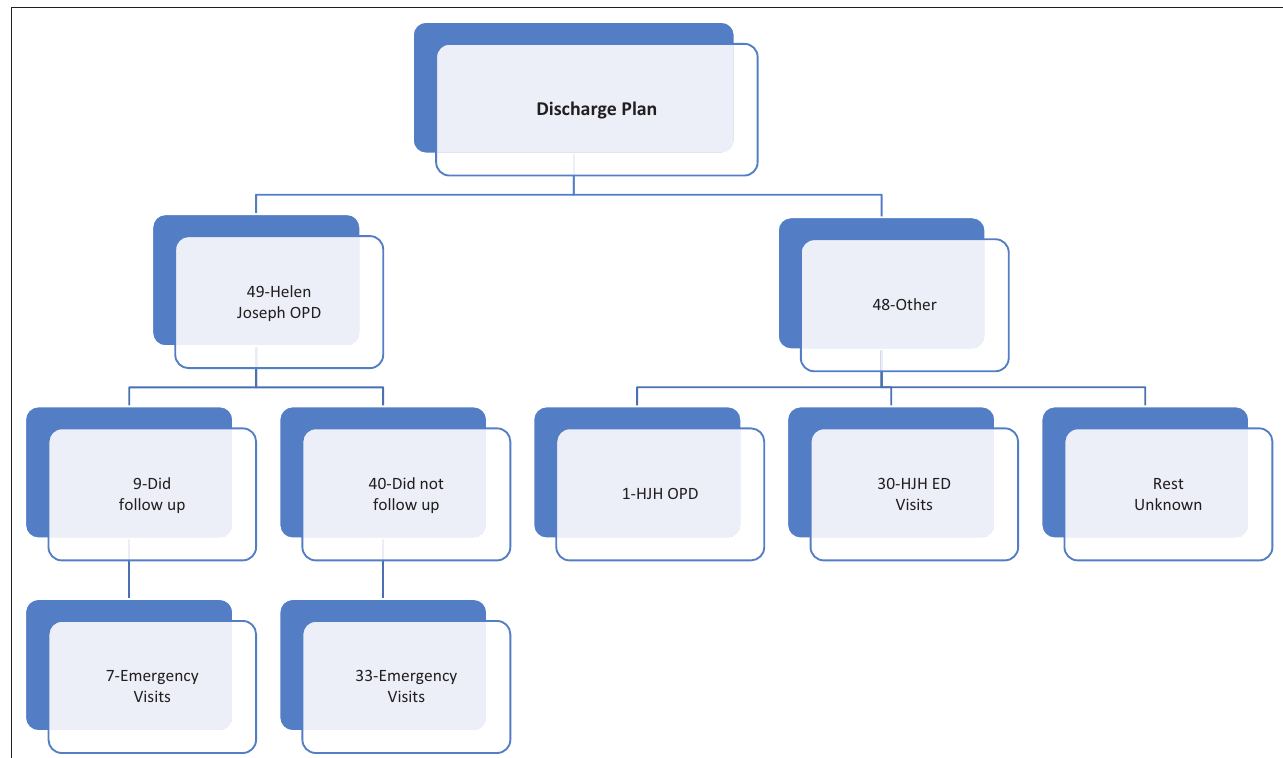
FIGURE 6: Tracking of patients after being discharged with a diagnosis of borderline